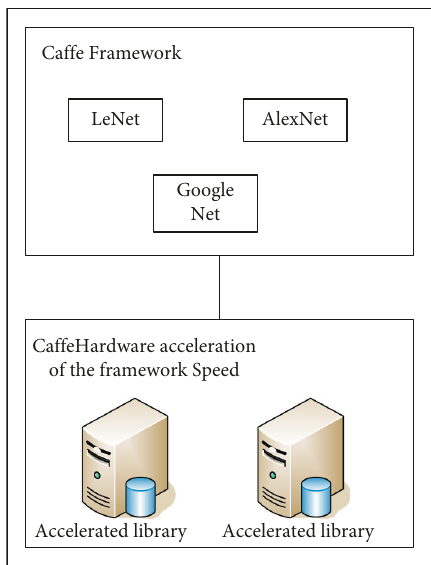
Figure 3: Deep learning analytics platform architecture diagram.